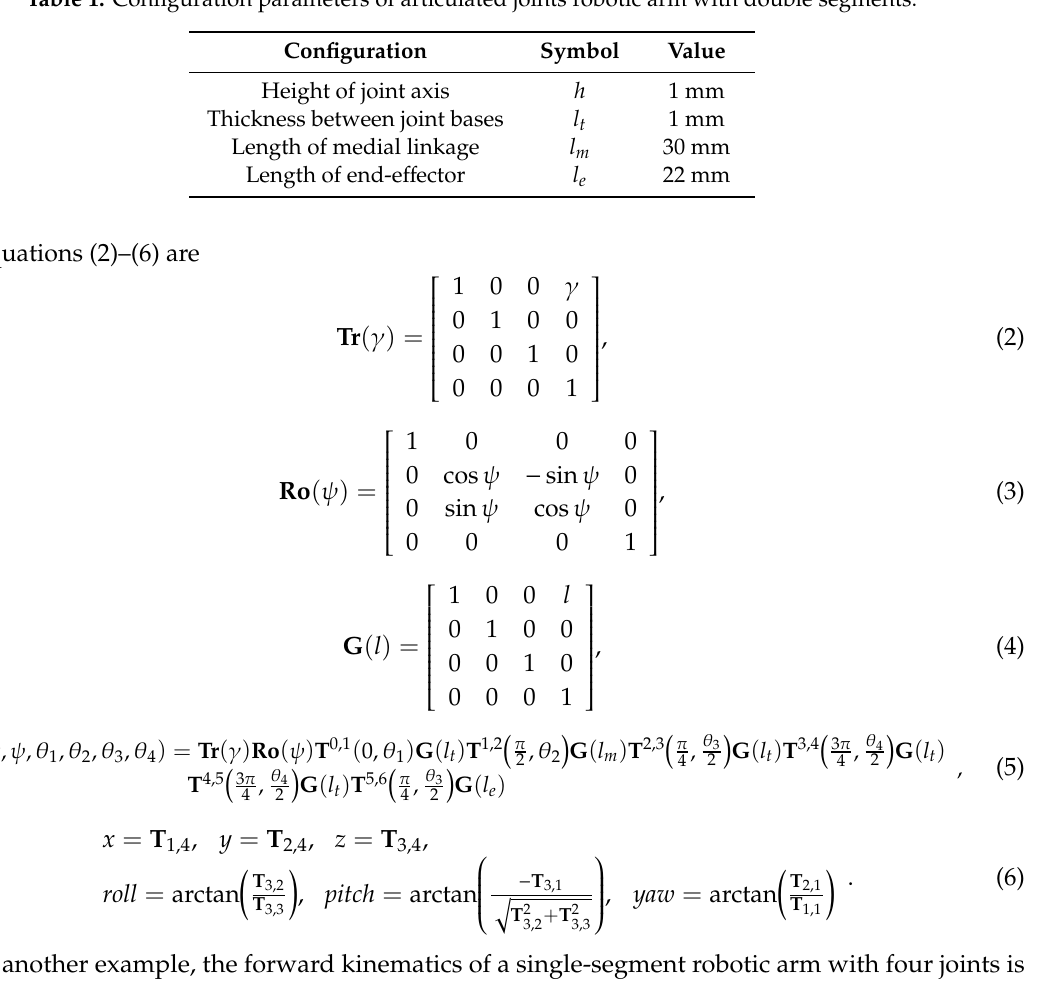
Table 1. Configuration parameters of articulated joints robotic arm with double